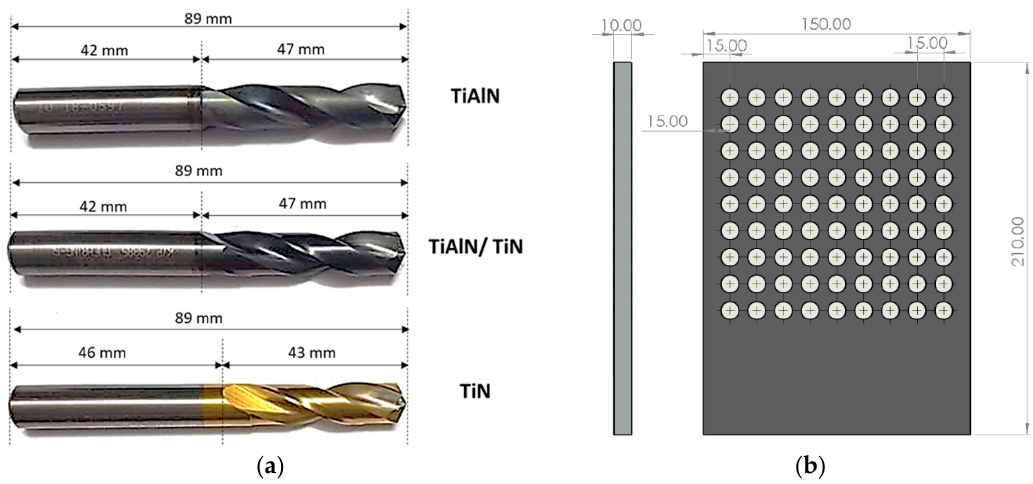
Figure 1. Details of ( a ) side view of the three types of cutting tools used in the study, and ( b ) plate dimensions and hole-array setup. Table 3. Details of the cutting-tool materials and coatings Adapted with permission from ref. [12]. Copyright 2019